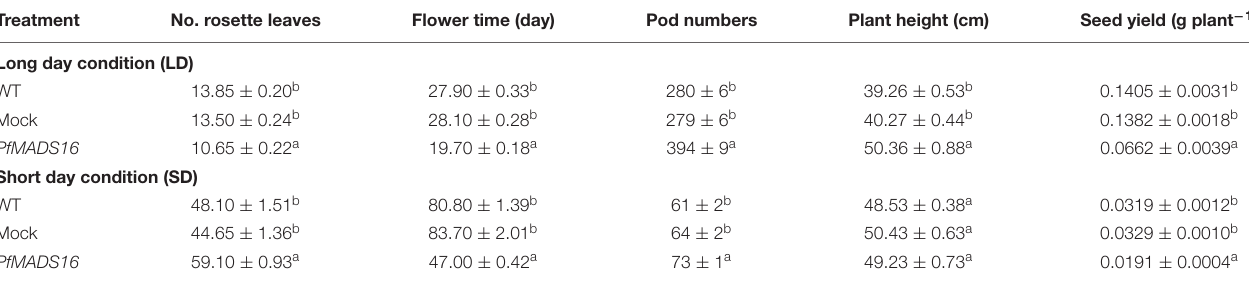
Data was mean ± SE of 20 Arabidopsis plants from four T3 lines. Different letters in a column indicate a significant difference based on Ducan’s multiple comparison test, p < 0.01.